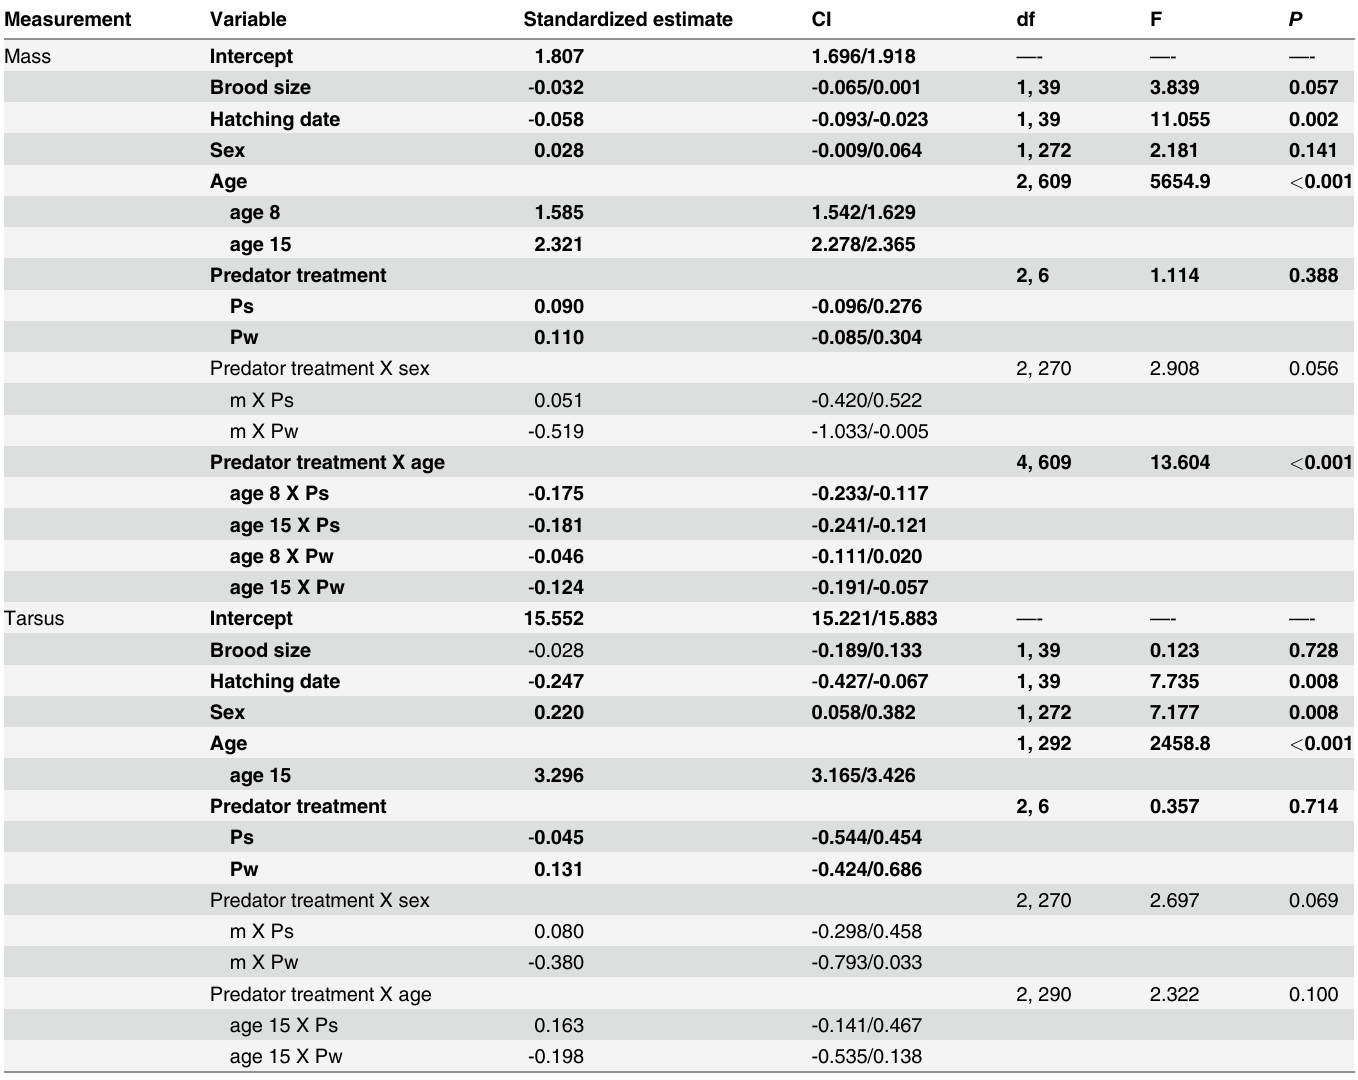
Table 2. ANOVA table of LMMs for nestling and